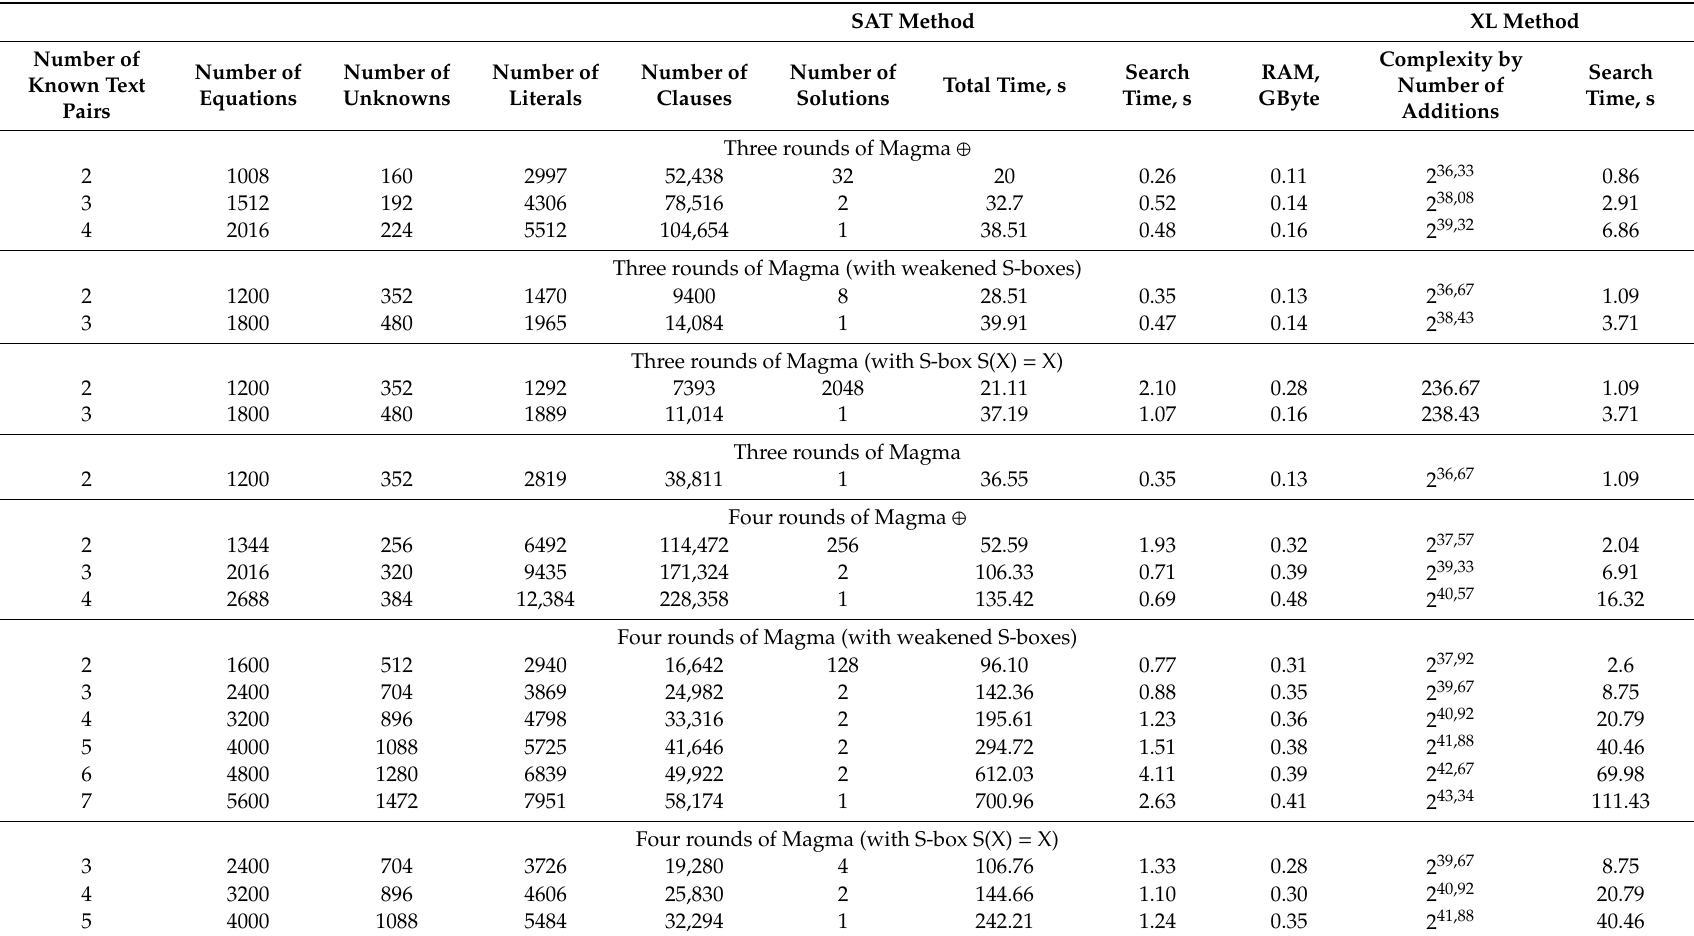
Table 5. Algebraic analysis of